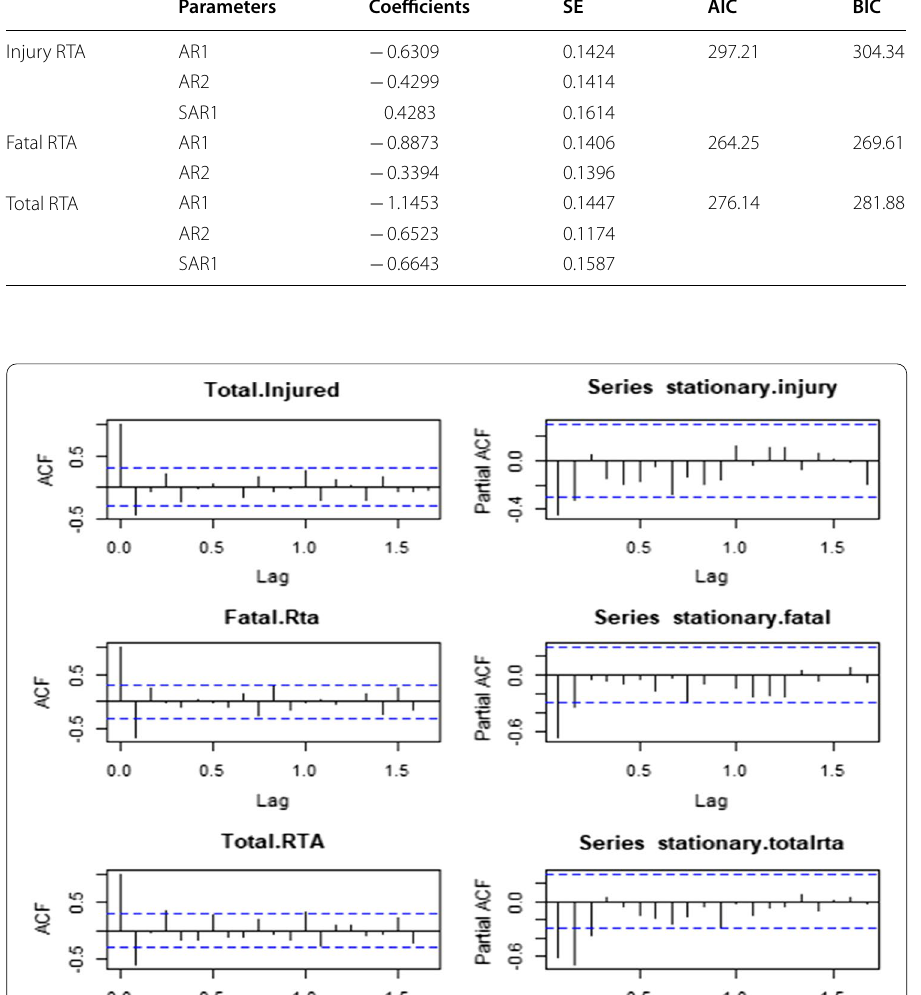
Table 6 Parameter estimates & goodness of fit measures of injury, fatal and total RTA Parameters